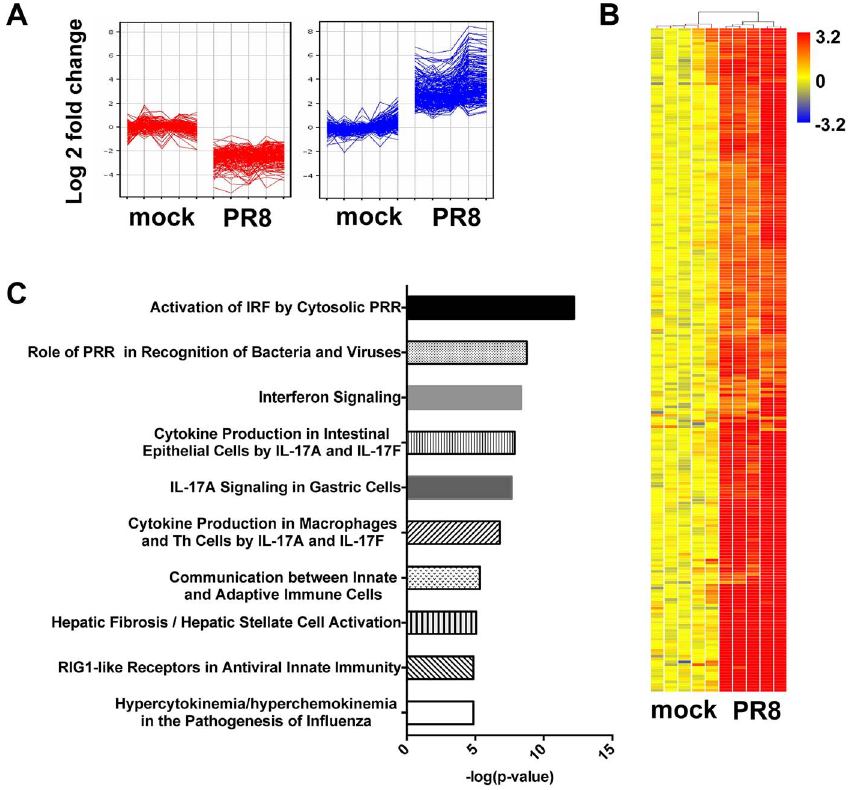
Figure 2. In primary MTEC, influenza A infection induces an IFN signature. Total RNA from mock and PR8 infected cells was analysed using Affymetrix Mouse Genome 430 2.0 microarrays at 24 hpi. Supervised analysis was performed using statistical filtering ( $ 4-fold change relative to mock infected; t-test unpaired, p , 0.01, Benjamini-Hochberg multiple test correction). (A) K-means clustering of the differentially expressed genes. (B) Heat map of the 234 upregulated-gene, as shown in (A). The range of fold changes is expressed in a log2 scale. (C) Ingenuity Pathway Analysis of the upregulated genes in influenza infected MTEC.